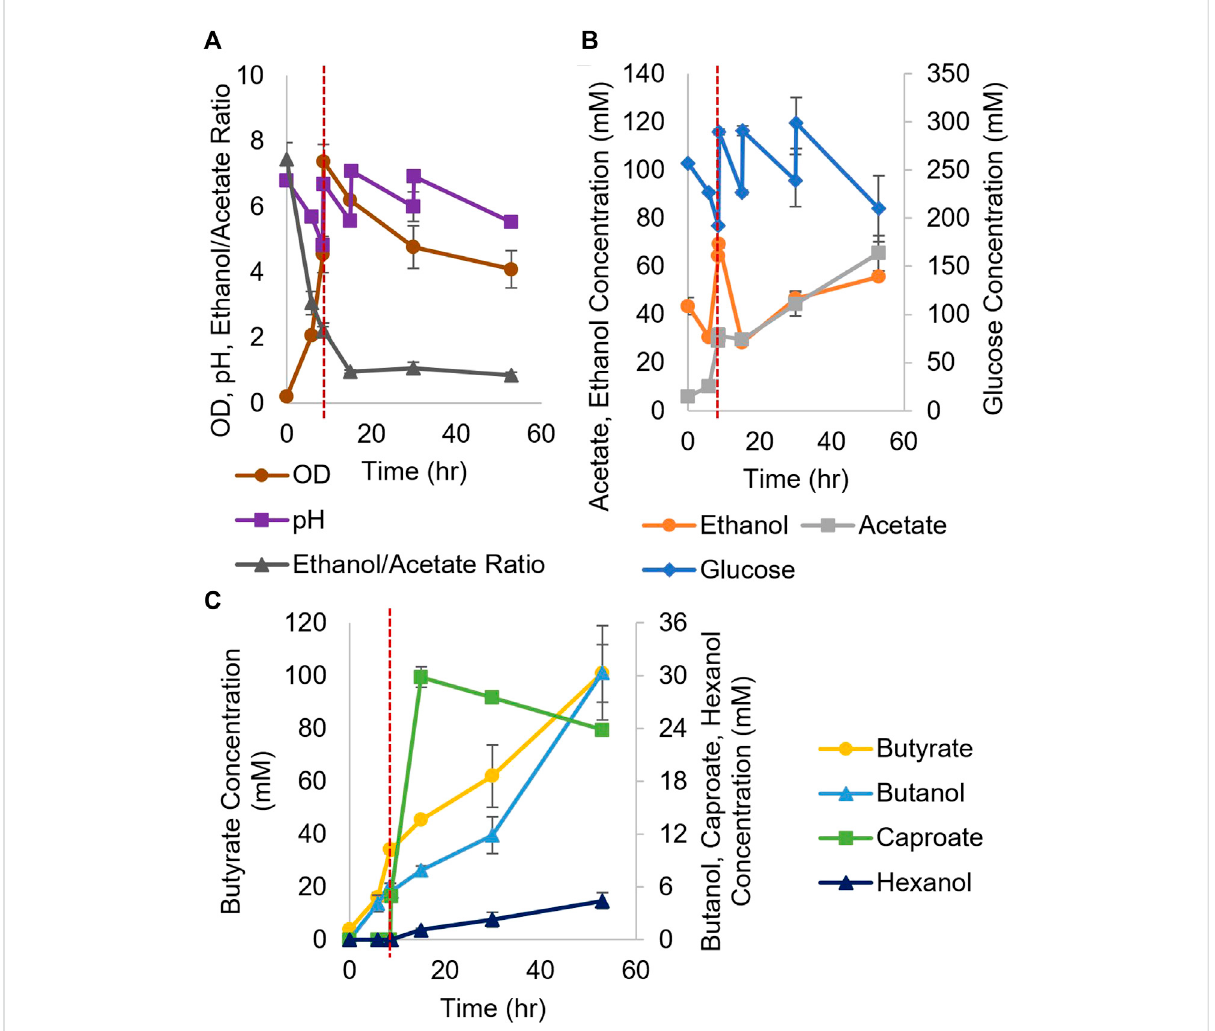
FIGURE 3 Growth and metabolite pro fi les of WT Cac / Ckl syntrophic cocultures. The pH was adjusted three times (A) ( n = 3 biological replicates). In (B) , glucose was added three times (note the second axis) and ethanol titers remained low throughout the fermentation. 4- to 6-C product pro fi les are shown in (C) (note the second axis). Caproate was produced quickly, reaching its maximum titer at 20 h. The red dashed vertical line indicates Ckl